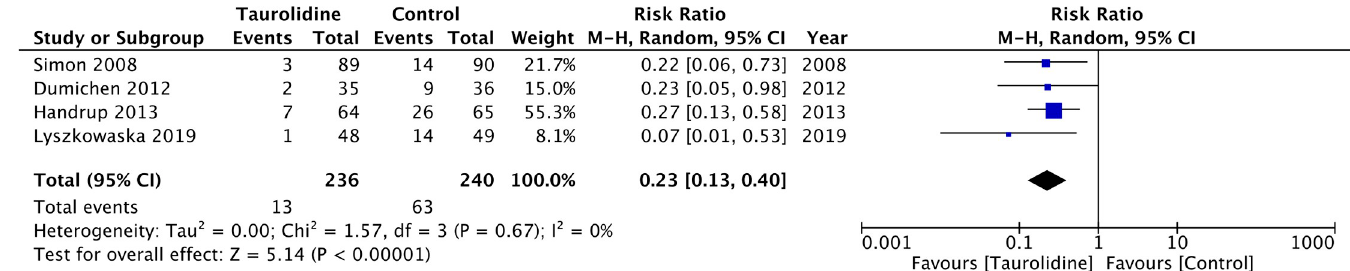
Fig 3. Forest plot of taurolidine versus control for the total number of CRBSI.